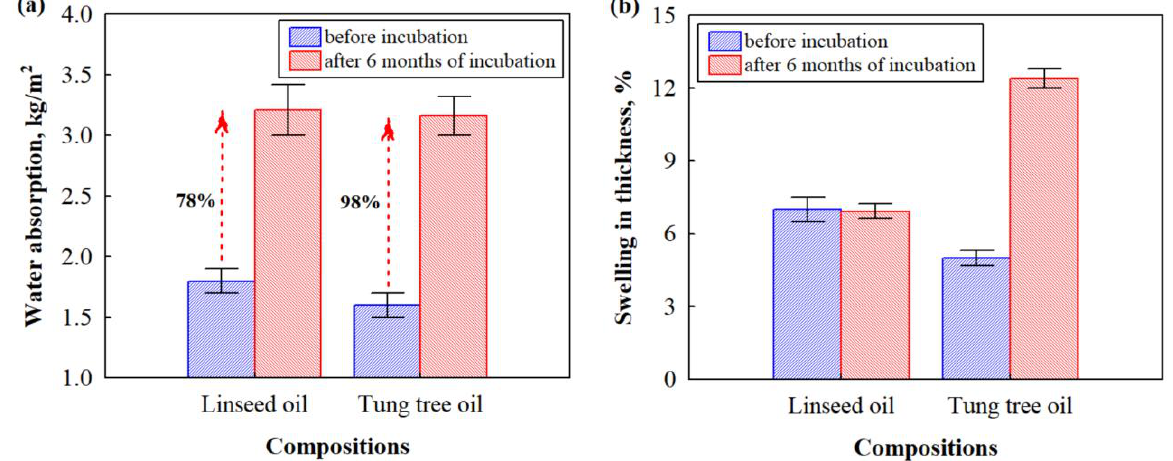
Figure 7. Moisture-related properties of HS- and CS-based biocomposites impregnated with different oils before and after incubation for 6 months: ( a ) short-term water absorption after immersion in water for 24 h; ( b ) swelling in thickness after immersion in water for 24 h.